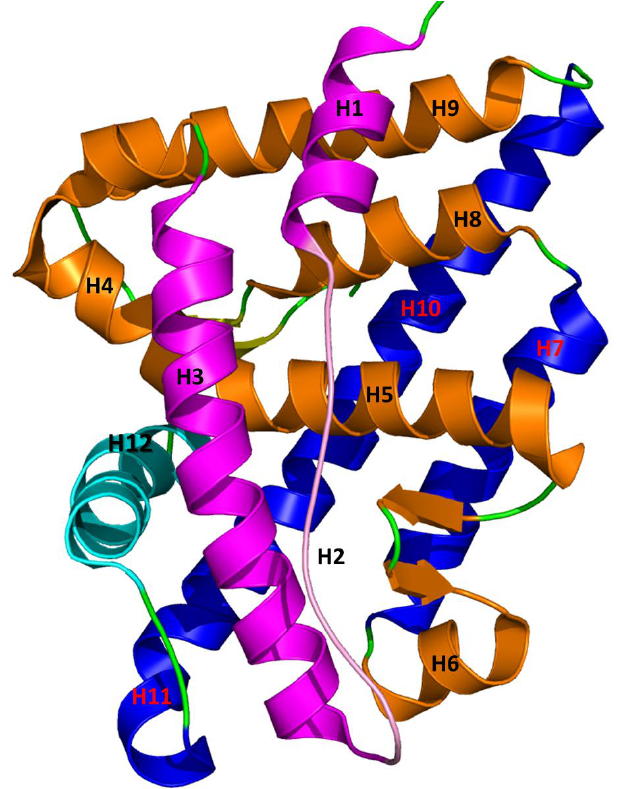
Figure 1. Three-dimensional structure of ligand binding domain of wild-type androgen receptor (WT-AR). The helices in ligand binding domain were arranged in a three-layered antiparallel α-helical sandwich fold. The first layer consists of H1 and H2 which are colored in magenta; the second layer contains H4, H5, H8, H9, and the first β-sheet which are colored in orange; and the third layer has H10 and H12, which are colored in blue and cyan, respectively. H12 acts as a lid in the entrance of the ligands binding pocket.